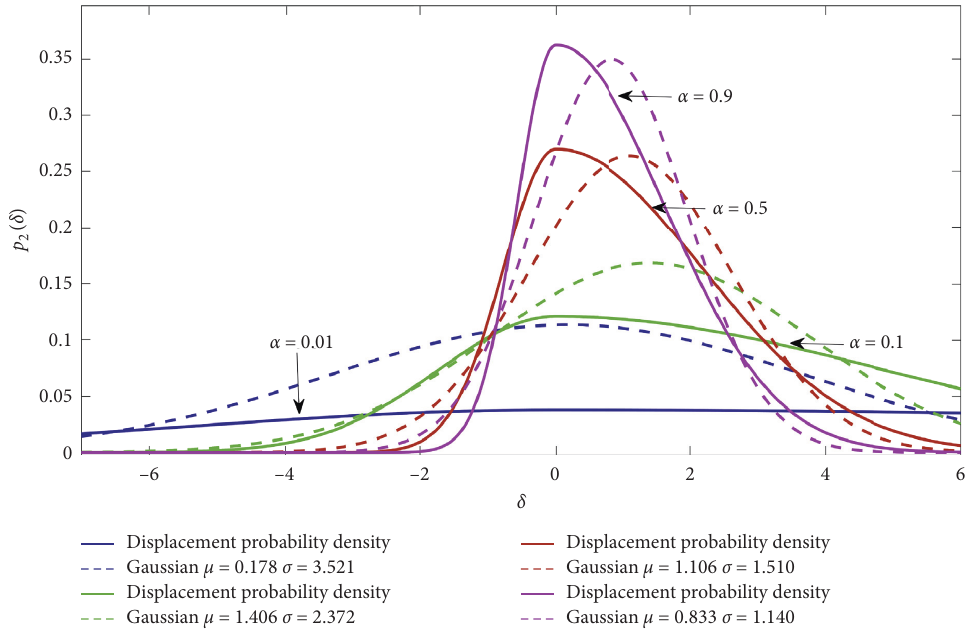
Figure 11: Displacement PDFs of AHTNPS for various values of σ 2 of Gaussian fitting.